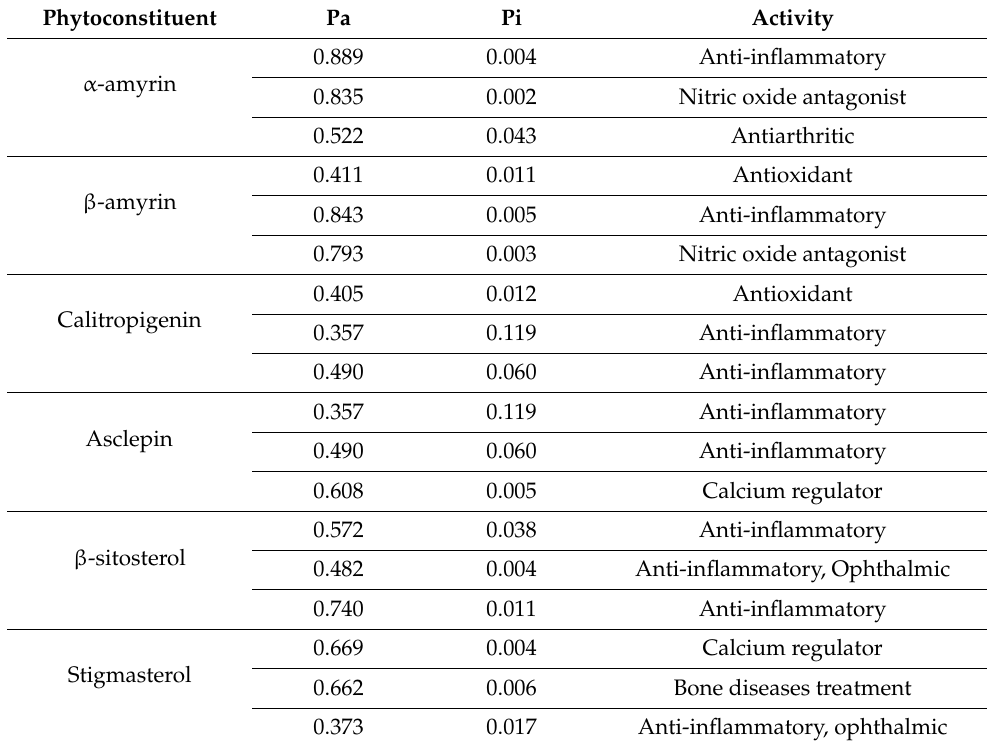
Table 1. Prediction of activity spectra for substance (PASS) of Swallow wort for antiarthritic activity.